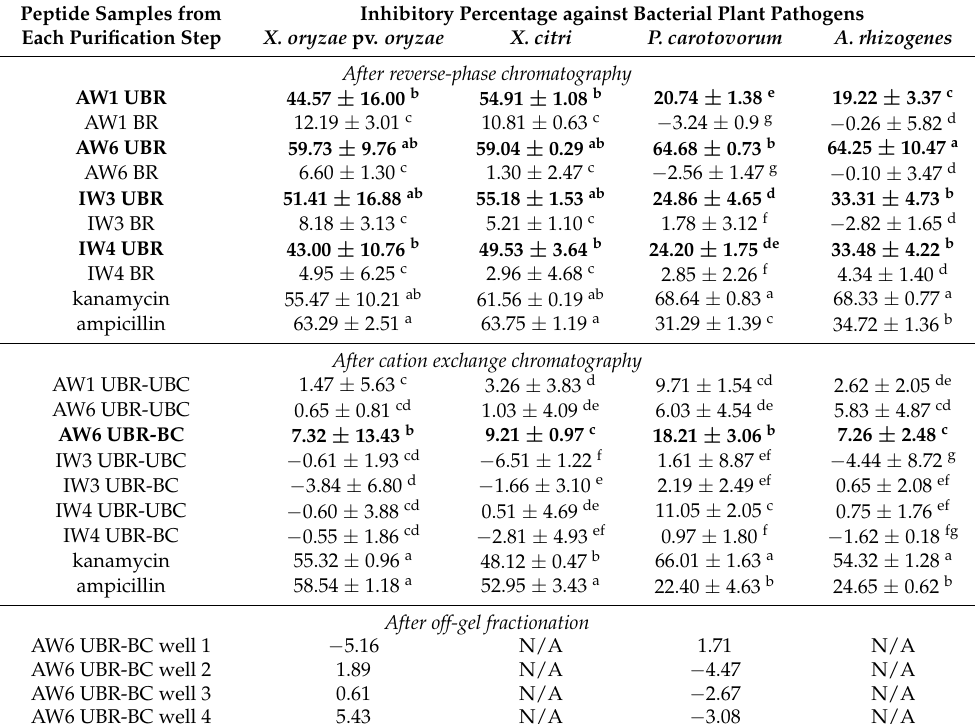
Table 4. Observed inhibitory percentages of purified peptide samples against growth of plant pathogenic